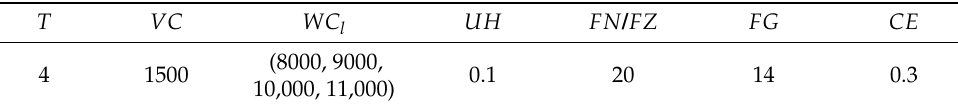
Table 3. Key input parameters.